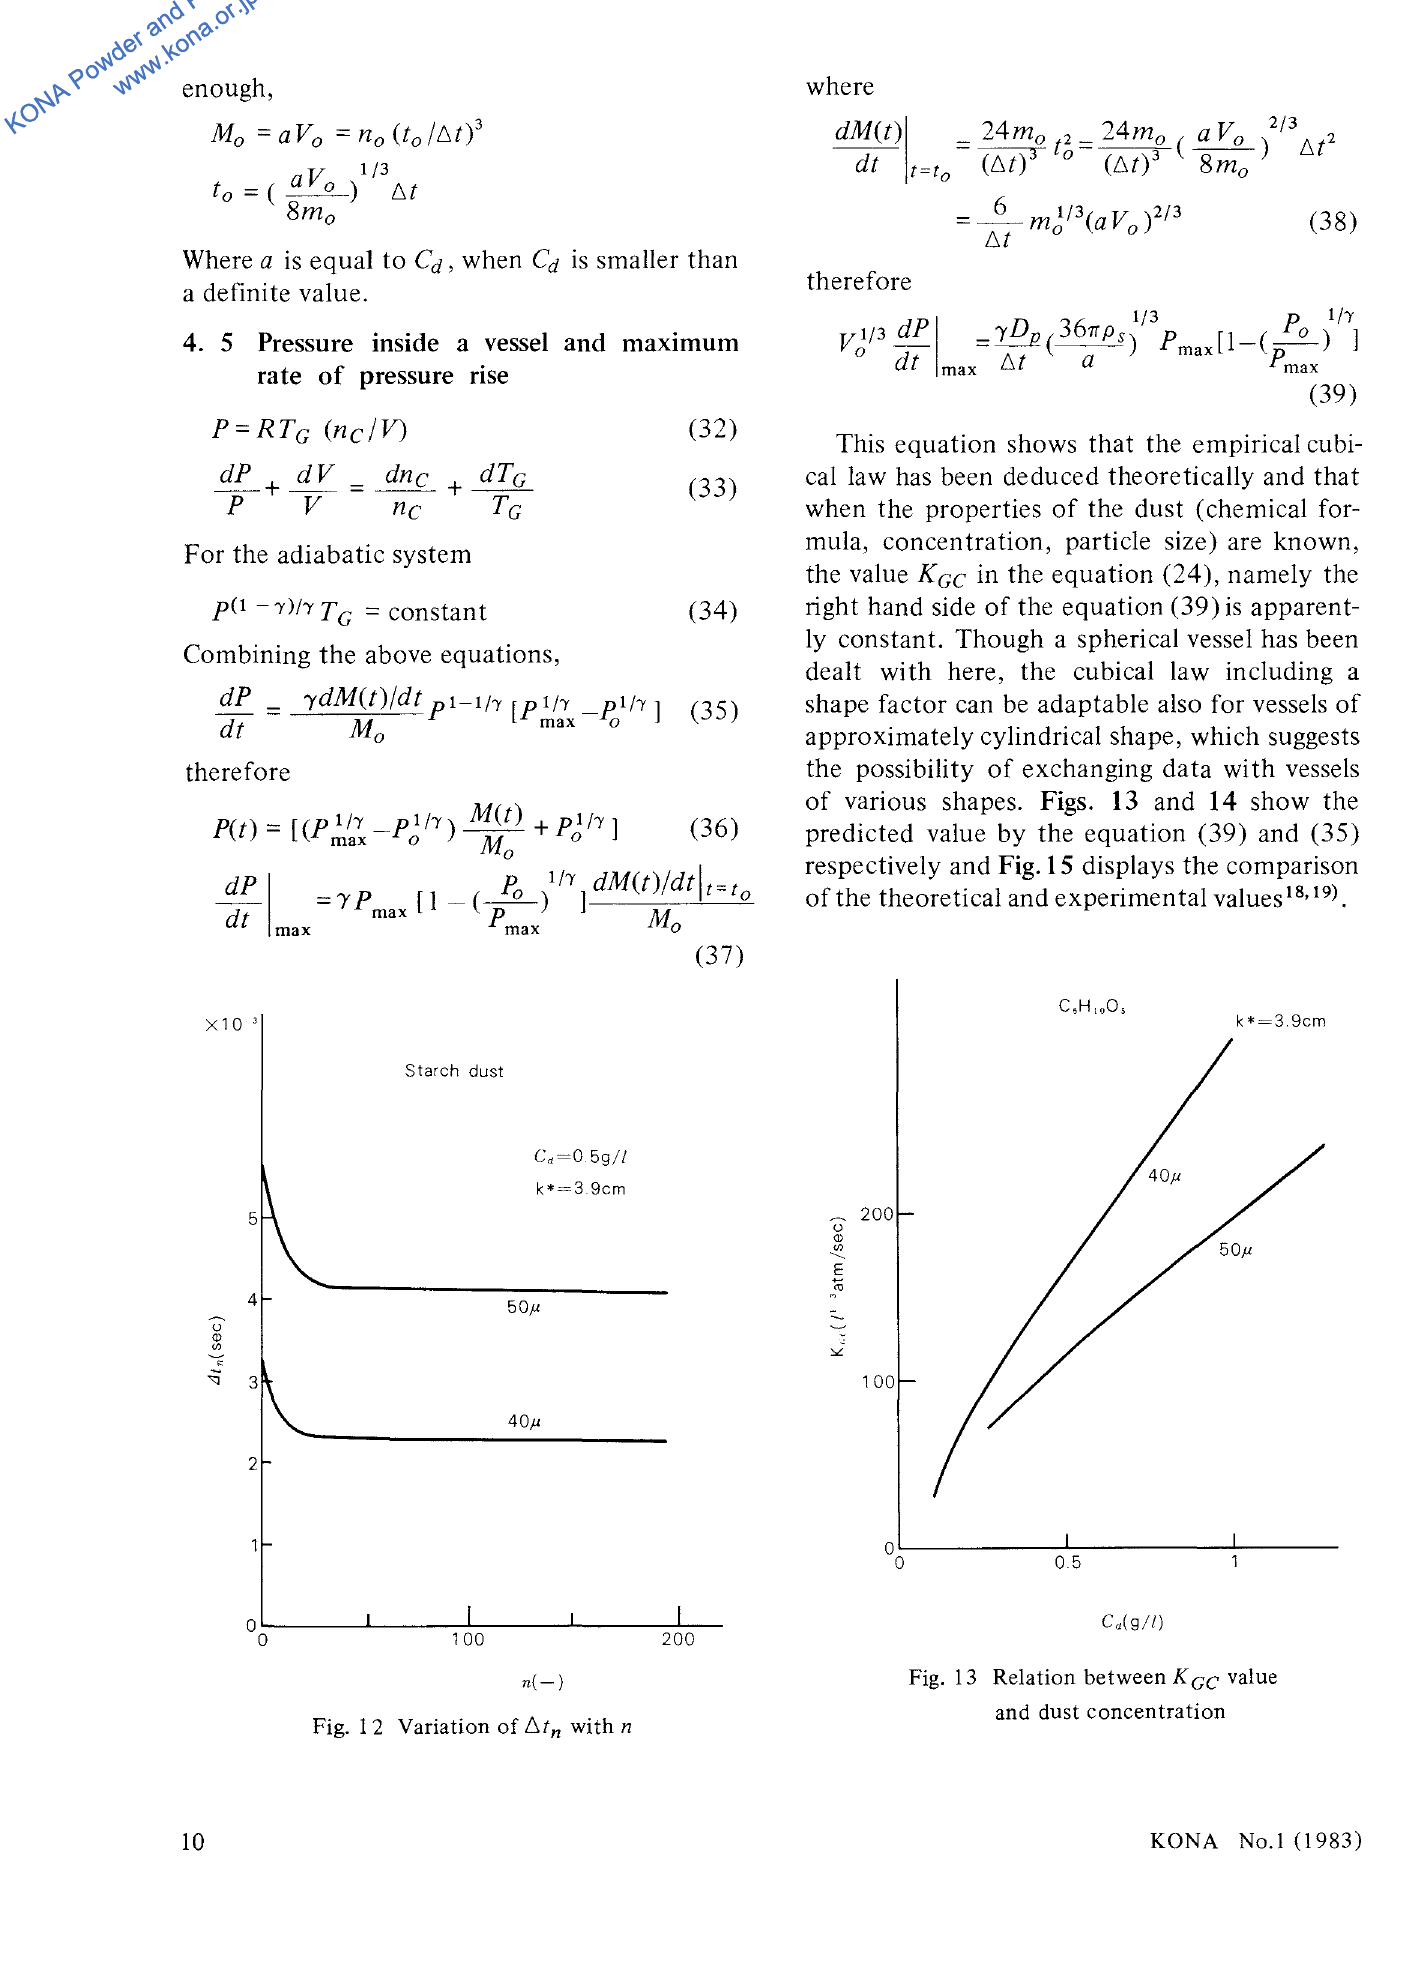
Fig. 12 Variation of l:.tn with n